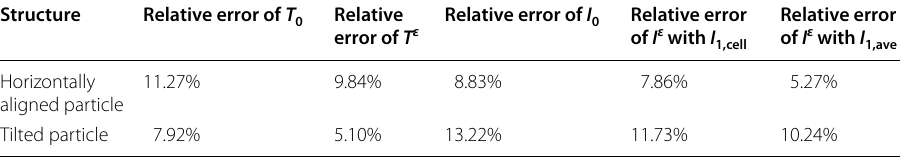
Relative error of I 0 Relative error Relative error error of T ε of I ε with I 1,cell of I ε with I 1,ave